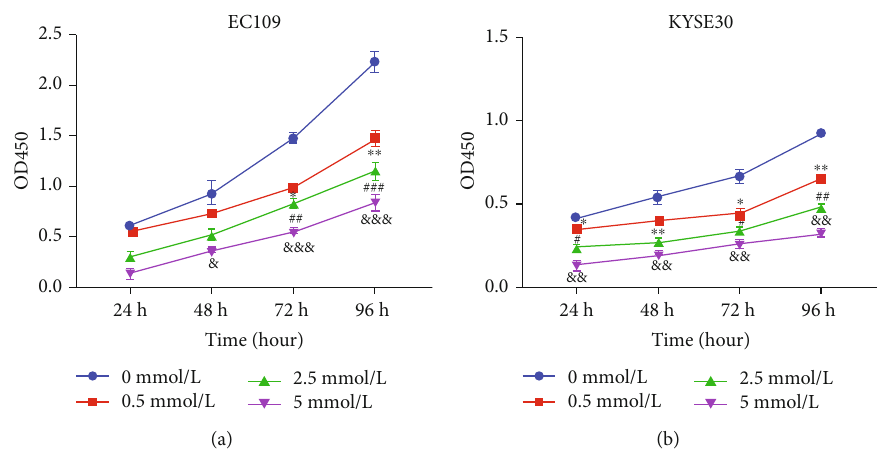
Figure 5: E ff ect of aspirin stimulation on proliferation of ESCC cells. (a and b) CCK-8 proliferation analysis was performed to assess the impact of aspirin on the proliferation of ESCC cells. ∗ , #, & P < 0 : 05 , ∗∗ , ##, && P < 0 : 001 , ###, &&& P < 0 : 0001 .